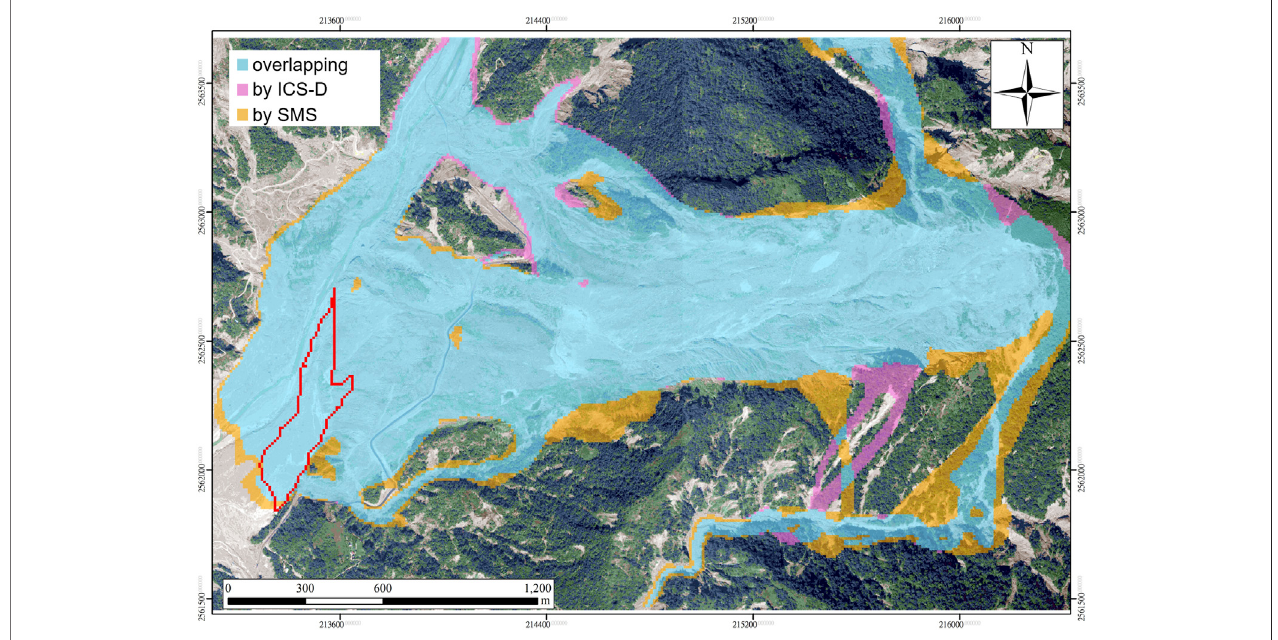
FIGURE 7 | Difference in the fl ow paths computed with the ICS-D and the smooth minimal surface method (SMS method), where the magenta area indicates the pathsonlybytheICS-D,theyellowareadenotestheareaonlytheSMSsurface,andthecyanmeansthecommon fl owpathsduringthesimulationperiod(from t (cid:1) 0sto t (cid:1) 181.83 s). The Hsiaolin village is depicted by the red contour. (Orthophoto: Courtesy of Aerial Survey Of fi ce, Forestry Bureau, Taiwan).